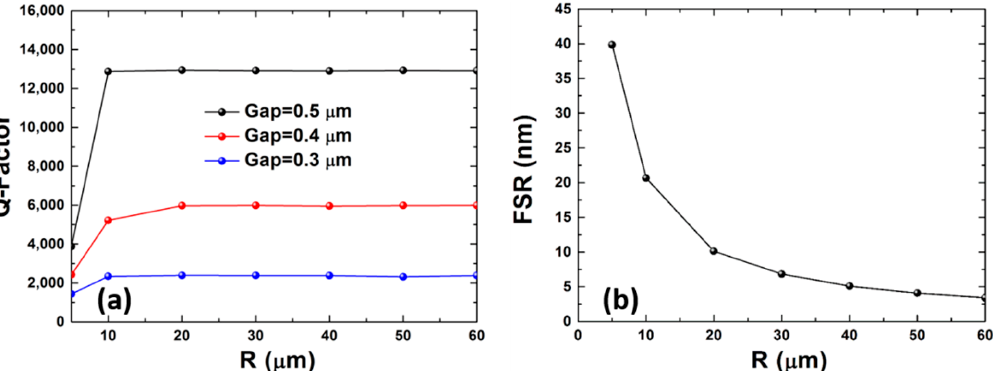
Figure 4. Graphs for ( a ) the Q-factor of the microring resonators at different ring radii and gap sizes and ( b ) the FSR at different microring radii for a TM light mode at around λ = 1.55 μ m.